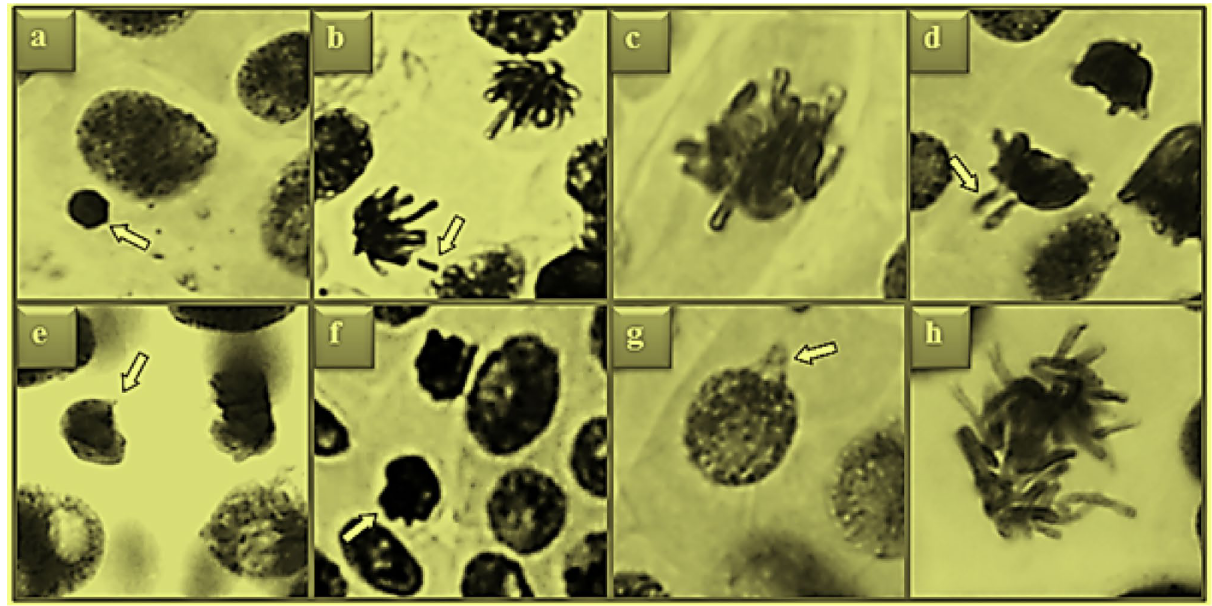
Figure 4. Chromosomal aberrations induced by potassium bromate. MN ( a ), fragment ( b ), sticky chromosome ( c ), vagrant chromosome ( d ), unequal distribution of chromatin ( e ), reverse polarization ( f ), nuclear bud ( g ), irregular mitosis ( h